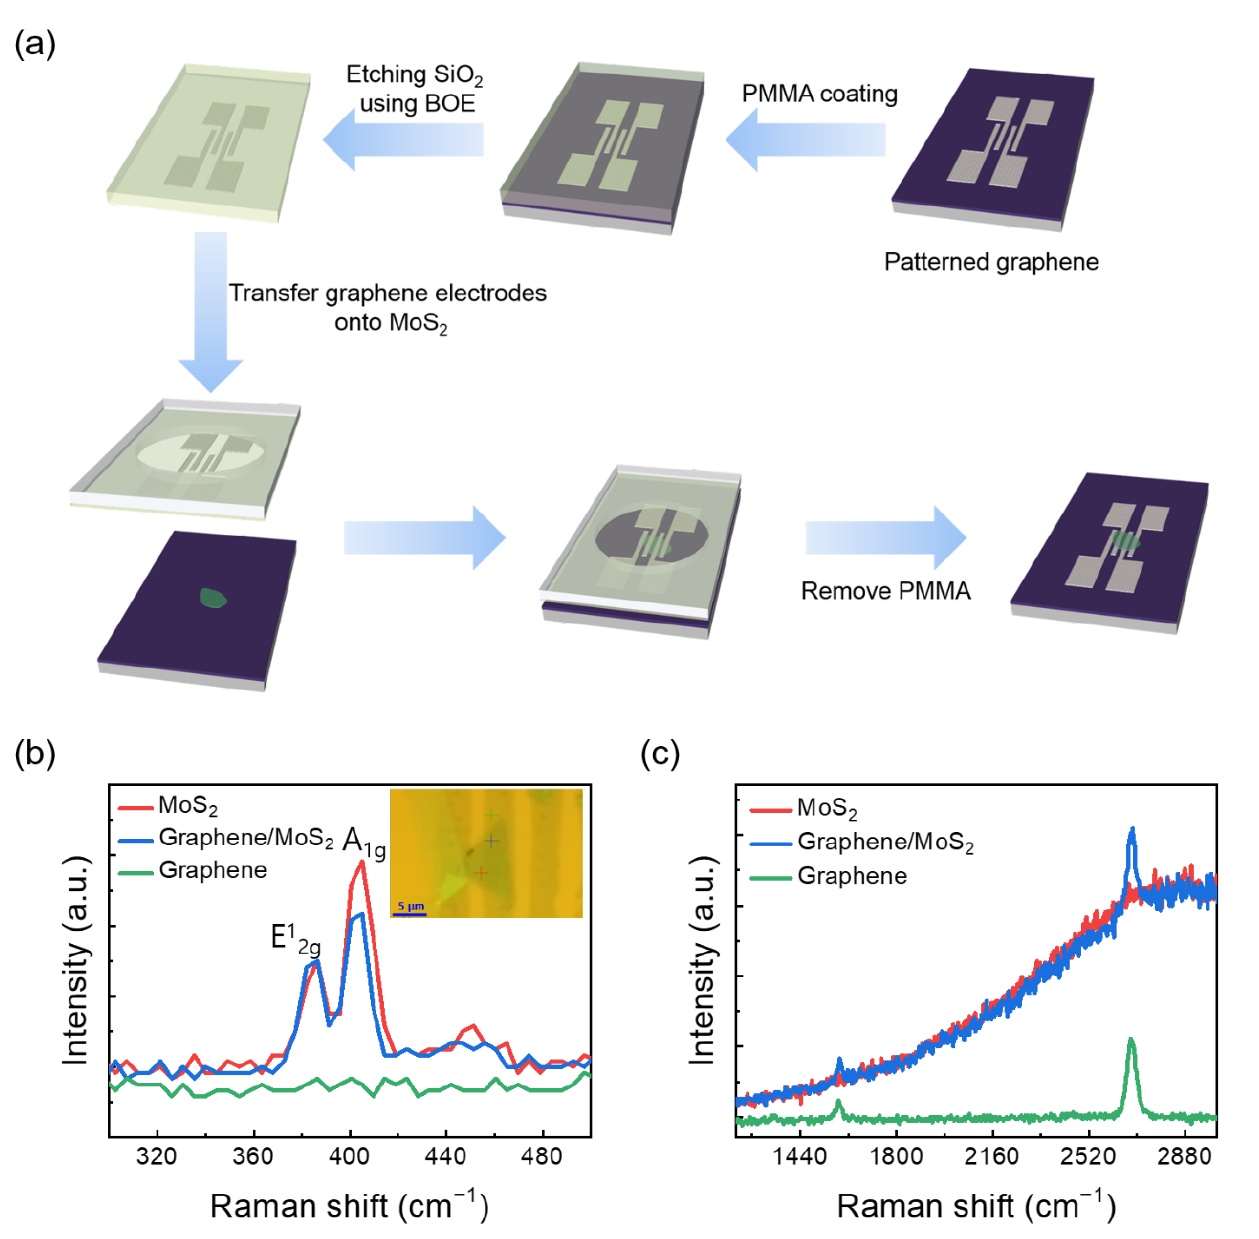
Figure 1. ( a ) Schematics illustration of the fabrication process for MoS 2 FET with graphene electrode. Raman spectroscopy of mechanically exfoliated single–layer MoS 2 (red), chemical vapor deposition (CVD)-grown graphene on single-layer MoS 2 (blue), and CVD-grown graphene (green). ( b ) MoS 2 region, and ( c ) graphene region of the Raman spectrum (the insert of ( b ) shows the Raman analysis position by cross mark).